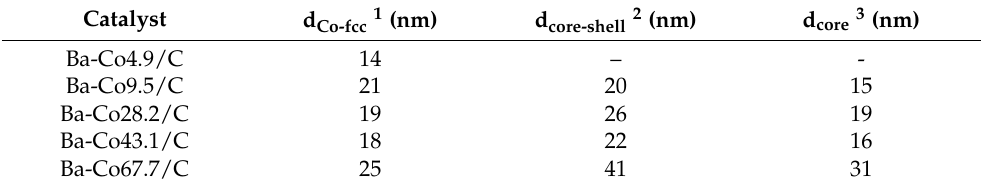
Figure 2. XRPD patterns of the Ba-Co/C catalysts (the spent catalysts after exposure to air—ex situ measurements). Table 1. Average cobalt crystallite and cobalt particle size in the Ba-Co/C catalysts based on XRPD and TEM measurements (the spent catalysts after exposure to air—ex situ